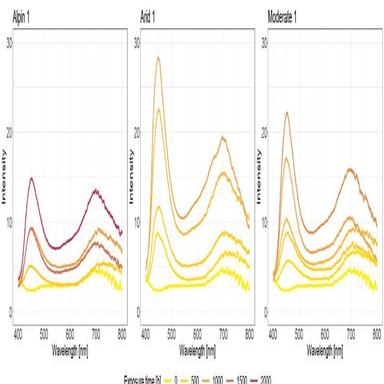
Examples of UV-F spectra (time series) of test module encapsulations after exposure to Alpine 1, Arid 1 or Moderate 1 climate test conditions.